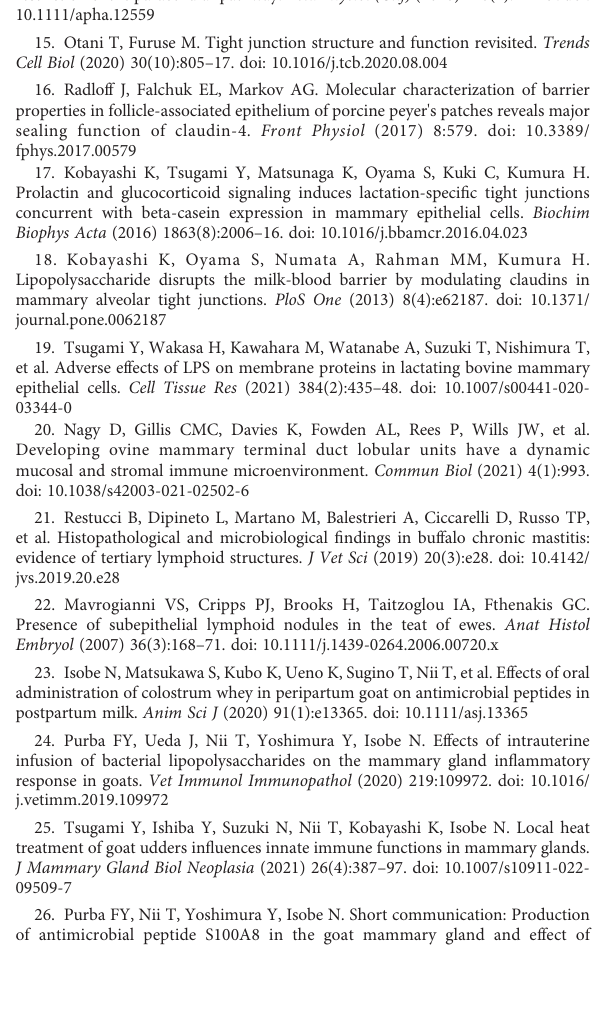
Supplementary Figure 1 Representative images of hematoxylin and eosin (HE) staining and immunohistochemistry against CD20 (B cells), CD3 (T cells), MECA79(highendothelialvenules;HEVs),CD40(folliculardendriticcells),and BCL6 (germinal center) in lymph nodes of lactating goats. Scale bar, 100 m m. Supplementary Figure 2 (A) Representative images of hematoxylin and eosin (HE) staining and immunohistochemistry against MECA79 (high endothelial venules; HEVs). Images of the same position are shown. Representative images of immuno fl uorescence against MECA79 and claudin-5 in lymph nodes (B) or mammary glands (C) of lactating goats. Claudin-5 is a marker for blood vessels. Scale bar, 100 m m. Supplementary Figure 3 (A) Representative images of negative control for immuno fl uorescence against secondary antibodies. Scale bar, 100 m m.